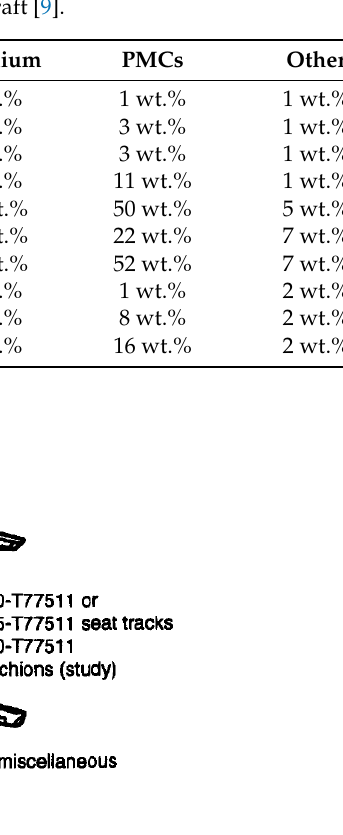
Figure 1. The use of aluminum alloy in Boeing 777 aircraft [9].